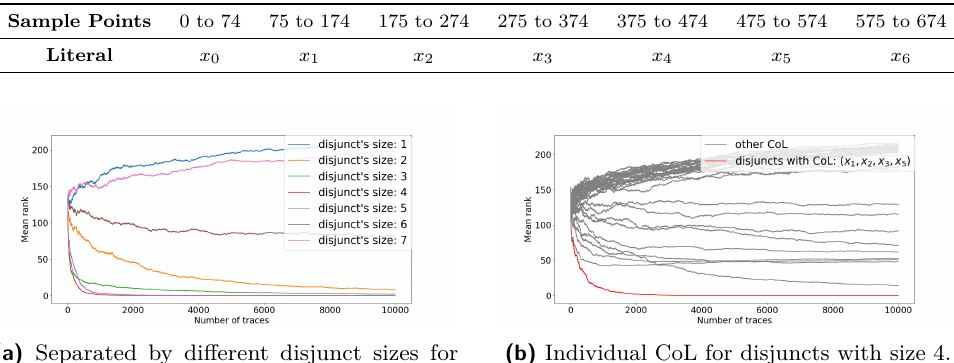
Table 5: Sample points for each literals for the TT-DCNN trained with padding of 25.